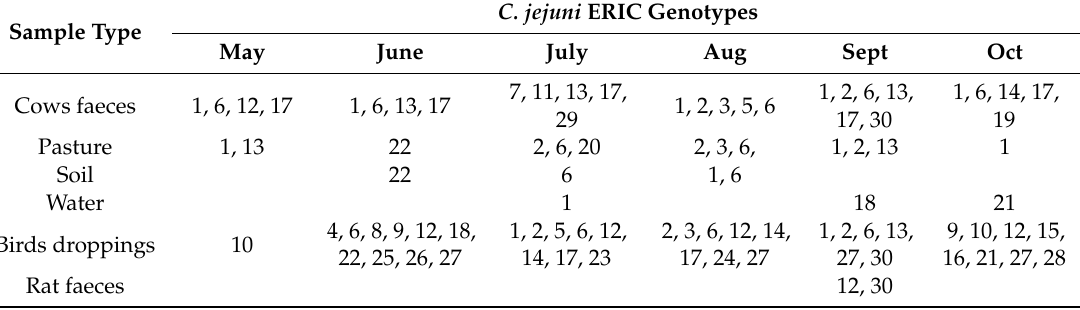
Table 3. Monthly detection of C. jejuni ERIC genotypes in cows, wildlife and the farm environment during the study period. Each genotype was assigned a numerical sequence (i.e., ERIC-type 1 to ERIC-type